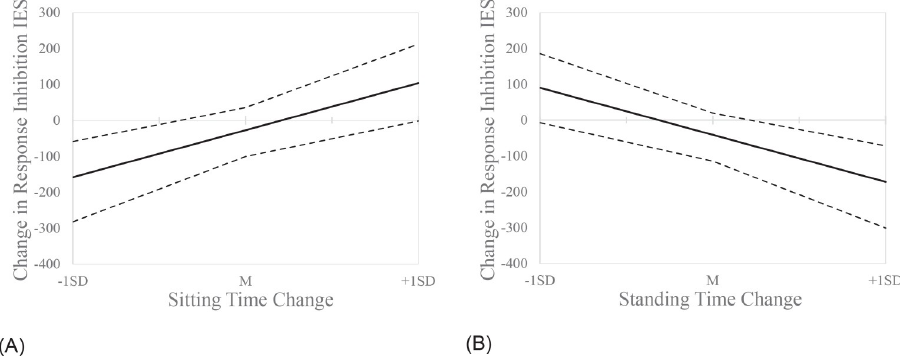
Fig 6. Interactive effects of the cognitively engaging active breaks at different levels of sitting (A) and standing time change (B). The solid lines represent the estimated values. The dotted lines show the upper and lower bootstrapped 95% confidence intervals. A response inhibition inverse efficiency score (IES) change is indicative of improved performance at end of trial compared to baseline. The plots show that when there was a reduction in the time spent sitting or an increase in the time spent stepping (by the end of trial compared to baseline) children doing the cognitively engaging active breaks had a significant positive effect on response inhibition (i.e., negative change in IES score). Conversely, the opposite effect was observed in case of a change in sitting time greater than +1 standard deviation (SD) (i.e., baseline–end Δ > 27.2 min) or a change in standing time lower than –1SD (i.e., baseline–end Δ < –23.2